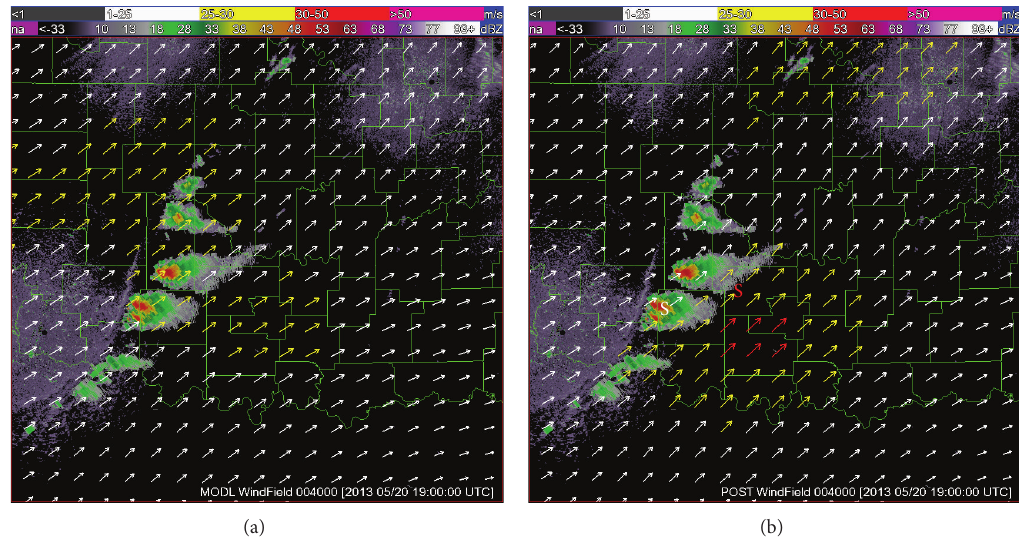
Figure 10: (a) As in Figure 7(b) but zoomed in around the supercell marked by the white letter S in Figure 7(b). (b) As in (a) but for the analyzed wind field produced by the upgraded RWAS. The white letter S in (b) marks the supercell (as in Figure 7(b)) that further intensified during the next two hours and moved to the location marked by the red letter S in